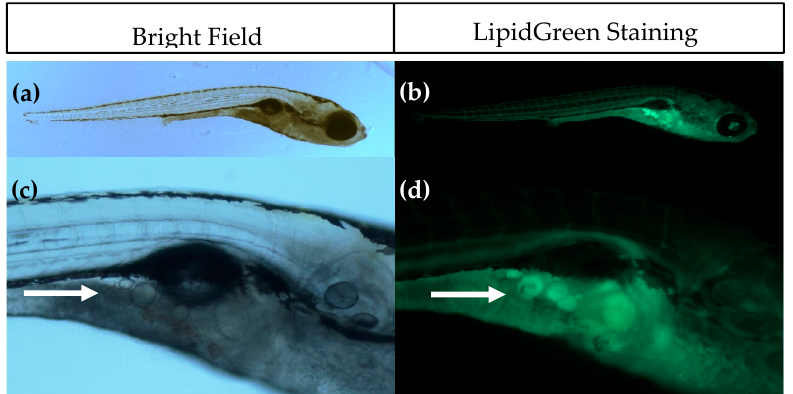
Figure 1. Imaging of adipocytes using Bright Field ( left ) and fluorescence microscopy after LipidGreen staining ( right ). ( a,b ) Representative images of a 15 days post fertilisation (dpf) larvae (5× magnification); ( c,d ) Close-up of the pancreatic area where the first adipocytes develop. Adipocytes are indicated with a white arrow (16× magnification).